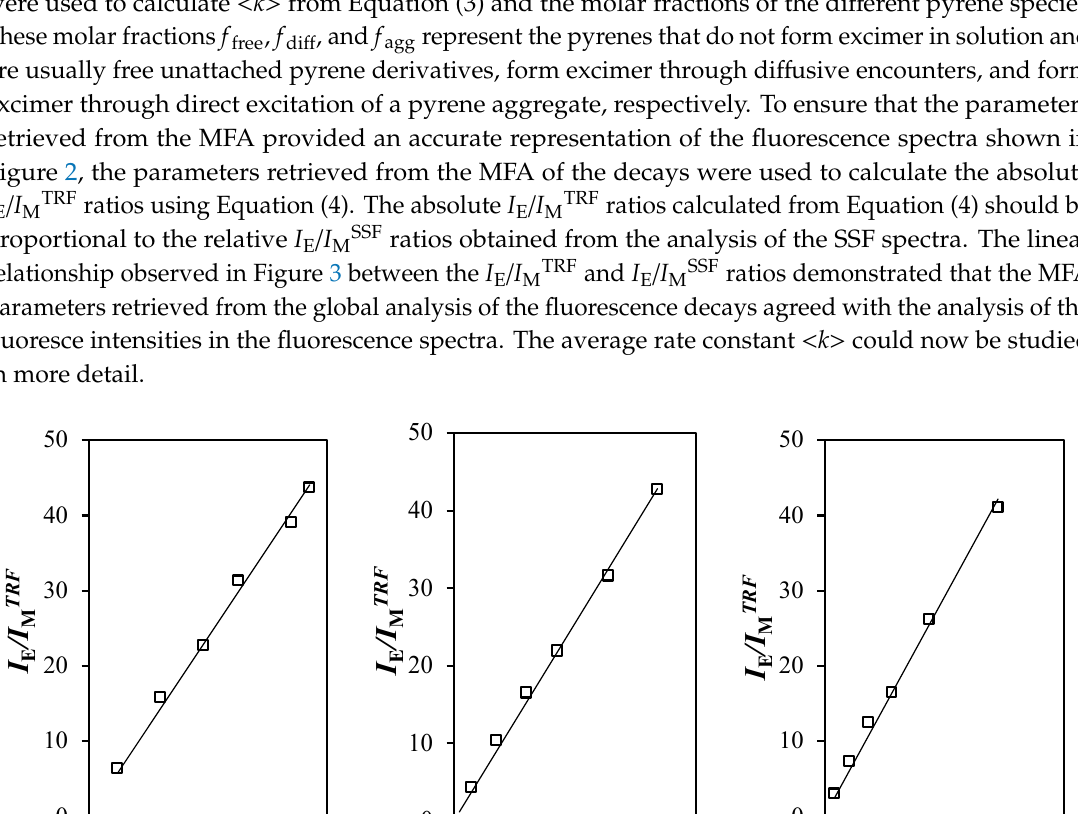
Figure 3. Plot of I E / I MTRF versus I E / I MSSF for the Py x -G( N ) samples in ( a ) toluene, ( b ) DMF, and ( c ) DMSO.